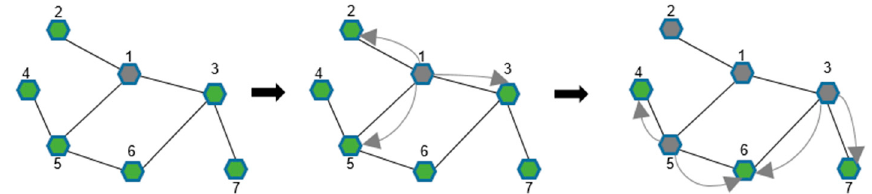
Figure 2. Cascading-failure process between cluster head